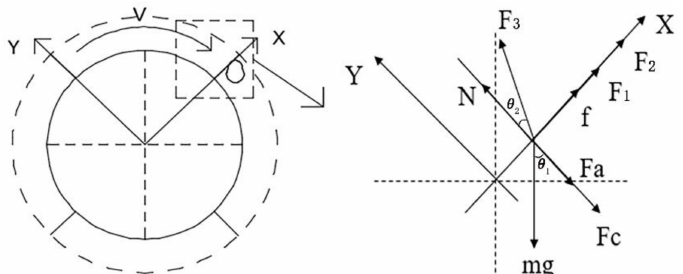
Figure 5. Stress analysis diagram of peanut picking process. F 1 denotes the force between the peanut stalk and the pod, N; F 2 is the force between the seedling vine and the peanut stalk, N; F 3 is the diagonal upward pull of the clamping chain, N; F c is the impact force of the picking roller blades on the peanut pods, N; N is the reaction force of F c , N; mg is gravity, N; f is the friction between the peanut pod and the picking blade,